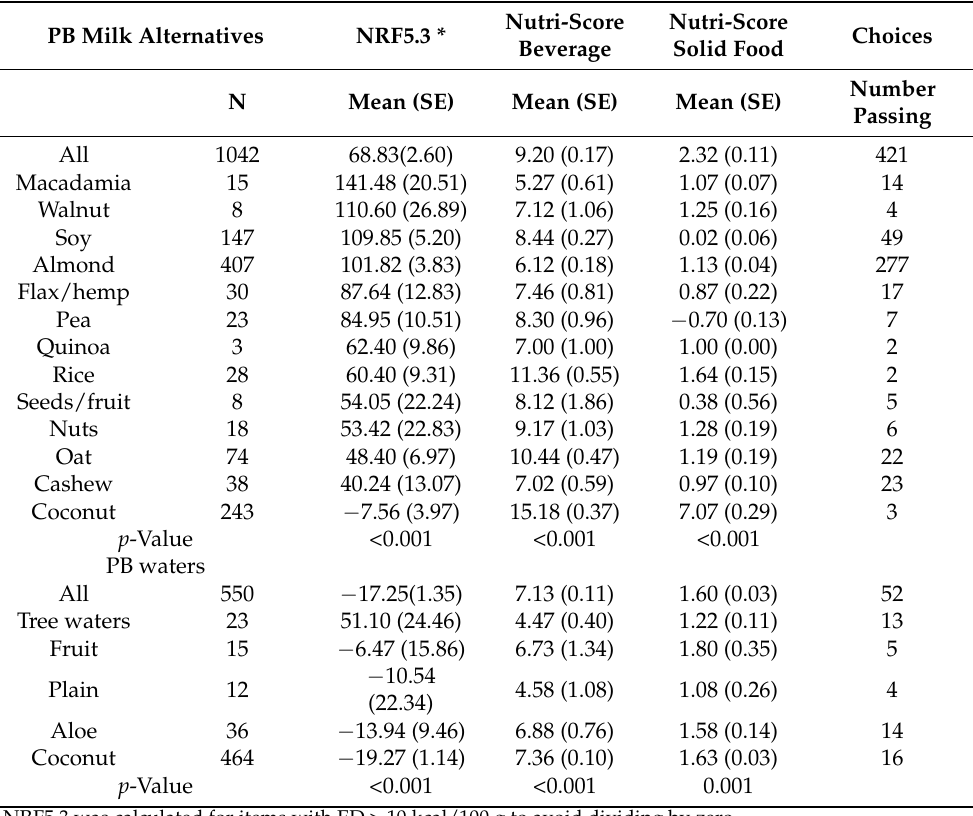
Table 4. Mean energy and nutrient density scores for PB milk alternatives and PB waters by product type and main ingredient. Data are means (SEM). Significance tests ( p -Values) are for column means. PB Milk